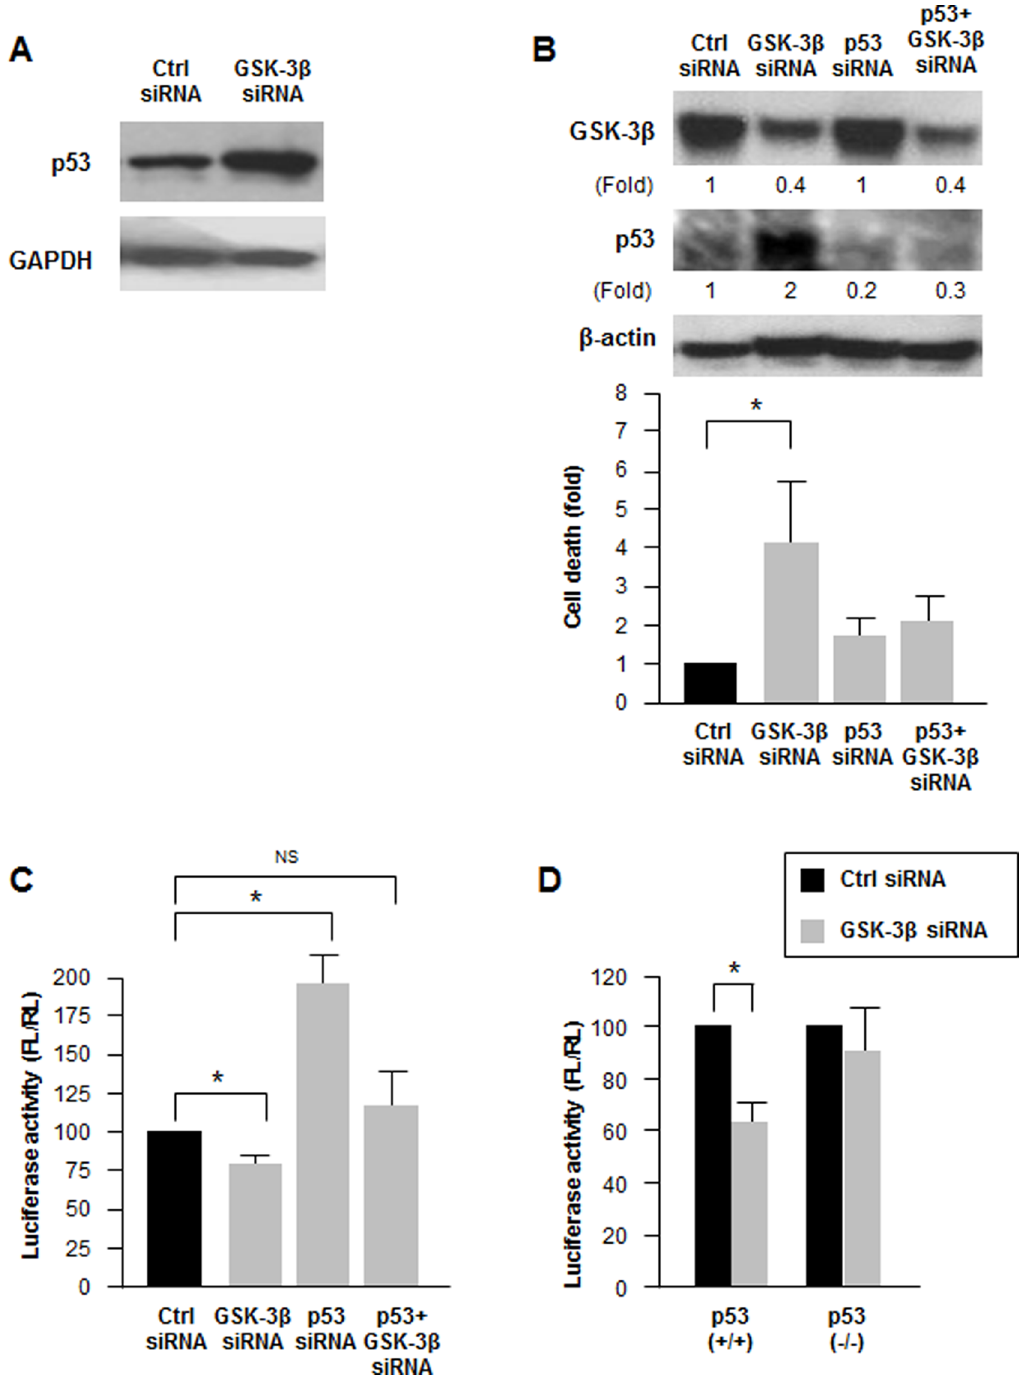
Figure 4. p53 is required for GSK-3 b regulation on let-7 activity. ( A ) Forty-eight hours after transfecting BG-1 cells with Ctrl or GSK-3 b siRNA as explained in Figure 2B, lysates were prepared to assess the levels of p53 and loading control GAPDH by western blot analysis. ( B ) Forty-eight hours after transfecting BG-1 cells with 50 nM Ctrl siRNA, GSK-3 b siRNA, and/or p53 siRNA, lysates were prepared to measure protein levels ( top ) and cells in the culture media were collected and counted ( graph ). Signals were quantified by densitometry and normalized to the levels of b -actin (Fold). ( C ) Twenty-four hours after transfection as described in panel (B), BG-1 cells were transfected with pmirGLO-let7 and luciferase activity was measured 24 h later. ( D ) Twenty-four hours after transfection with Ctrl or GSK-3 b siRNAs, HCT116 p53 + / + and p53 2 / 2 cells were transfected with pmirGLO-let7 and luciferase activity was measured 24 h later. Data in (B, C and D) are the means and S.D. from three independent experiments: * P , 0.05; NS, not significant.